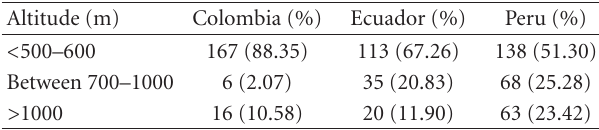
Table 1: Altitude that species inhabiting Amazonia reach in the